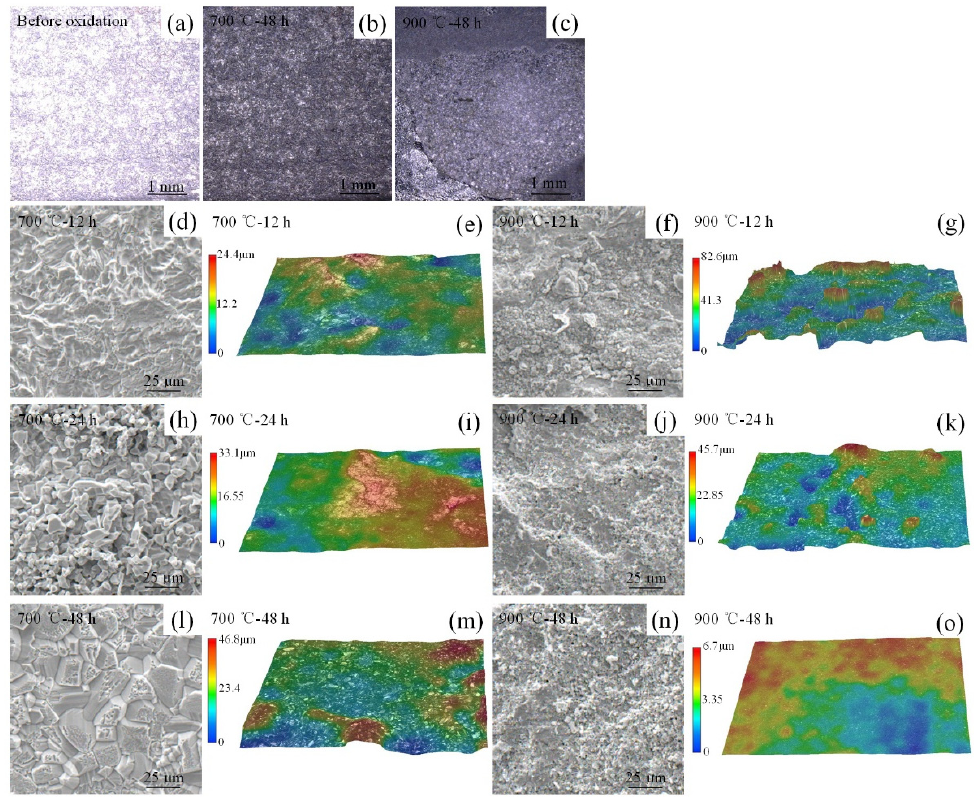
Figure 4. Surfaces micrographs of Cr-Mn-Fe-Co HEA at different temperatures and various times.